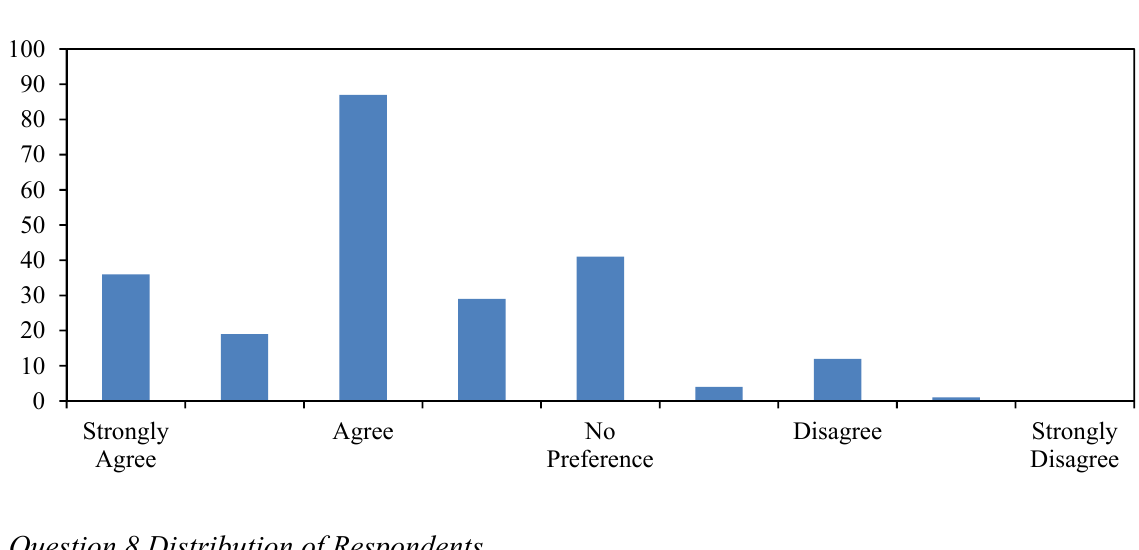
Figure 7. Graph of responses to the statement “I would trust computer analysis of data if I had access to or could evaluate the source